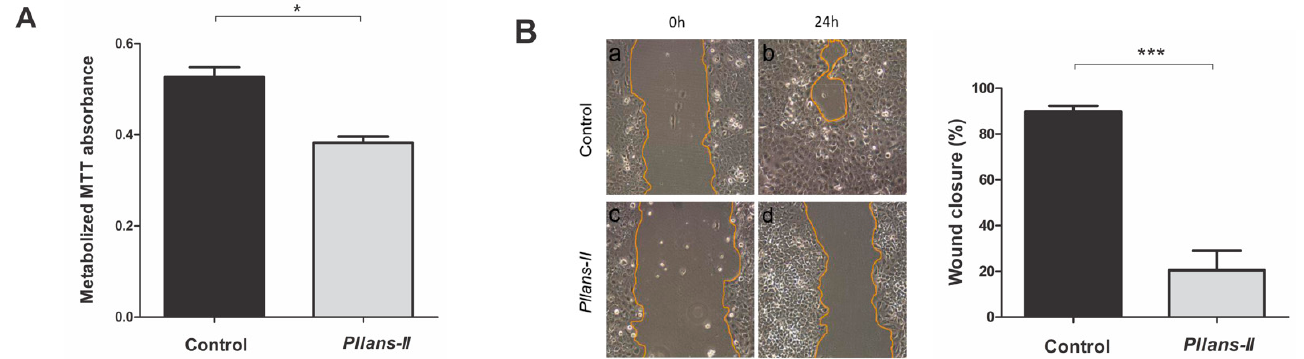
Figure 3. Pllans–II affects Ca Ski cells adhesion and migration. ( A ) Effect of Pllans–II on Ca Ski cell adhesion. Cells were incubated in RPMI medium alone (control) or with 100 µg/mL Pllans–II for 24 h. Metabolic activity was determined by MTT assay. ( B ) Migration effect of Pllans–II on Ca Ski cells by the wound healing assay. Cells were seeded at 5 × 10 4 cells/well in 24 well plates until obtaining complete confluence. After 24 h, the medium was discarded, and the confluent monolayer was scratched with a 10 µL pipette tip to create an area devoid of cells (0 h) ( a , c ). After this process, cells were treated in the ( a ) absence or ( c ) presence of Pllans–II at 100 µ g/mL. Pictures were taken at the beginning 0 h, ( a , c ) and the end of the experiment 24 h, ( b , d ), using an inverted optical microscope (Nikon Eclipse TS100). The bar graph shows the percentage of cell migration for Pllans–II and control after 24 h of incubation. The data are expressed as means ± SD ( n = 3). Statistically significant differences are observed between treatments with * p < 0.05 and *** p <